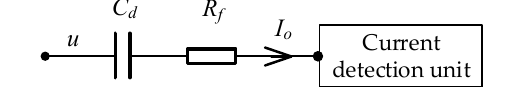
Figure 8. Simplified equivalent circuit of the measurement path of the logging instrument.